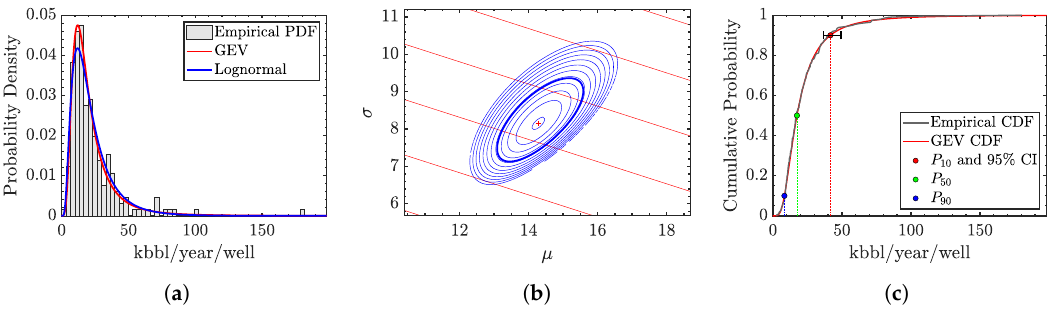
Figure 5. Distribution of oil production rates for 197 horizontal wells with seven years on production, completed between the year 2000 and 2012 in the Three Forks core area. ( a ) GEV PDF: ξ = 0.3368, µ = 14.2825, σ = 8.1499. ( b ) Maximum Likelihood Estimate, 95% confidence interval (CI) for µ and σ . ( c ) GEV CDF with the 95% CI on the residual for the P 10 well.